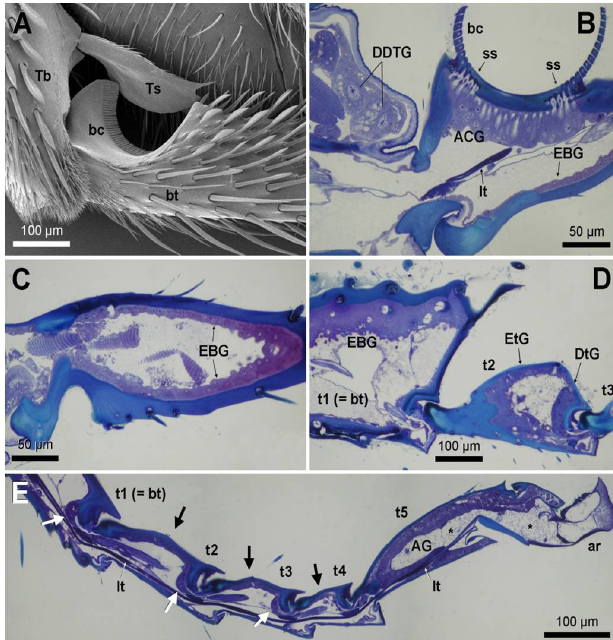
Fig 5 . A . Scanning micrograph of the antenna cleaning apparatus at the junction between the foreleg tibia (Tb) and basitarsus (bt), which is formed by the tibial spur (Ts) and a basitarsal comb (bc). B . Sec- tion through the foreleg tibia-basitarsus junction with indication of the dorsodistal tibial gland (DDTG), antenna cleaner gland (ACG) and epithelial basitarsal gland (EBG). C . Foreleg basitarsus with ep- ithelial basitarsal gland (EBG). D . Hindleg basitarsus and second tar- somere (t2), showing the epithelial basitarsal gland (EBG), epithelial tarsomere gland (EtG) and distal tarsomere gland (DtG). E . Section through foreleg tarsomeres with the arolium gland (AG), epithelial tarsomere glands (black arrows) and distal tarsomere glands (white arrows). ar: arolium, lt: leg tendon, ss: sensillar structures, t1-t5: tar- someres 1-5. The arolium gland lumen is marked with asterisks